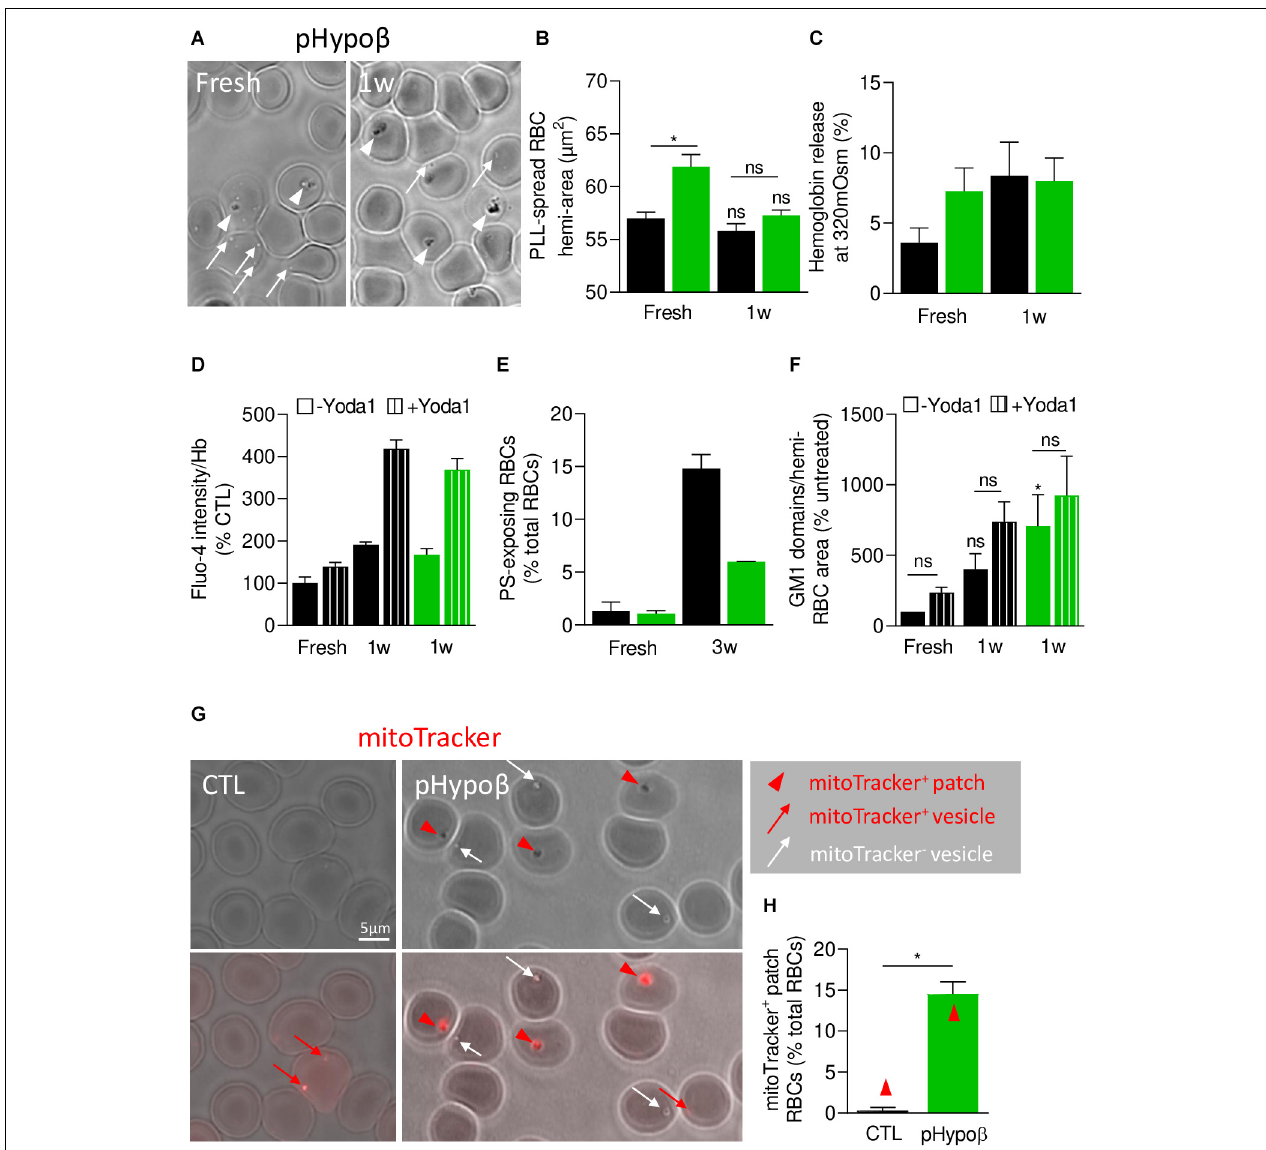
FIGURE 10 | pHypo β RBCs partly resist to RBC aging upon blood storage in K + /EDTA tubes at 4 ◦ C but exhibit a high abundance of residual mitochondrial fragments. RBCs from healthy donors (black columns) or pHypo β (green columns) were either stored for 1–3 weeks at 4 ◦ C (1-3w) and assessed for RBC morphology and surface area (A,B) , osmotic fragility (C) , calcium content (D) , PS surface exposure (E) and GM1-enriched domain abundance (F) ; or freshly analyzed for the presence of mitochondria remnants (G,H) . (A–F) RBC morphology and functionality upon storage at 4 ◦ C. (A) Morphology of fresh and 1 week-stored pHypo β RBCs immobilized on PLL-coated coverslips as in Figure 1D . Images are representative of 3 experiments. (B) RBC surface determined as in Figure 1I . Data are means ± SEM of 3–7 independent experiments. Wilcoxon matched-pairs signed rank tests and Mann–Whitney test; ns, not significant; * p < 0.05. (C) RBC fragility determined as in Figure 2A . Data are means ± SD of triplicates from 1 experiment. (D) RBC calcium content. RBCs were labeled with Fluo4-AM as in Figure 2F , incubated with Yoda1 (hatched columns) and analyzed by fluorimetry. Data are normalized to Hb content and are means ± SD of triplicates from 1 experiment. (E) RBC PS exposure assessed as in Figure 7E . Data are means ± SD of triplicates from 1 experiment. (F) GM1-enriched domain abundance on RBCs at resting state and upon stimulation with Yoda1 (hatched columns), determined as in Figure 8C . Data are means ± SEM of 3 independent experiments. Kruskal–Wallis test followed by Dunn’s comparison test and Wilcoxon matched-pairs signed rank tests for the effect of Yoda1. ns, not significant; * p < 0.05. (G,H) RBC evaluation for the presence of mitochondrial remnants. RBCs were incubated for 30 min with a fluorescent mitoTracker, washed, dropped on PLL-coated coverslips and immediately observed by fluorescence microscopy. (G) Representative images. Upper panels, transmission; lower panels, transmission with fluorescence. Red arrowheads, mitoTracker-positive patches; red arrows, mitoTracker-positive vesicles; white arrows, mitotracker-negative vesicles. (H) Relative proportion of RBCs presenting mitoTracker-labeled patches as percentage of total RBCs. Data are means ± SEM of 3–6 independent experiments. Mann–Whitney test. * p < 0.05.